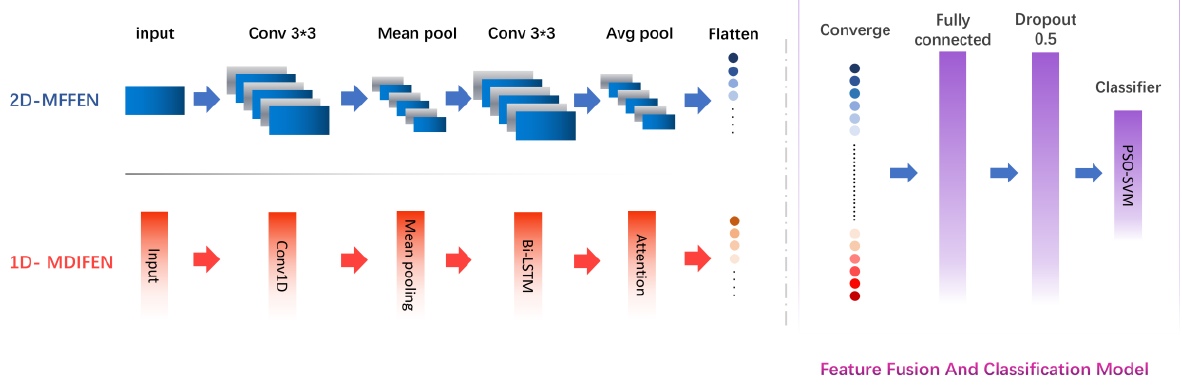
Figure 1. Molecular Information Fusion Neural Network model structure.